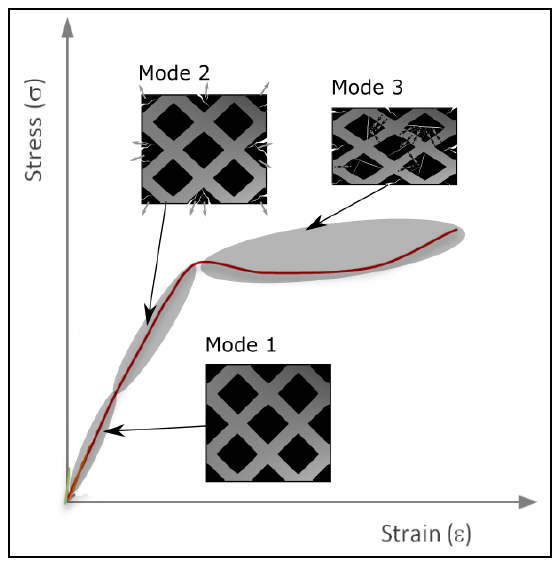
Figure 10. Schematic showing fracture mechanisms of metal–ceramic hybrids under compressive loading. Mode 1: rearrangement and elastic deformation of metal lattice; Mode 2: fracturing of ceramic surface elements; Mode 3: fracturing of the interior ceramic elements and embedding of these in ductile metal lattice.